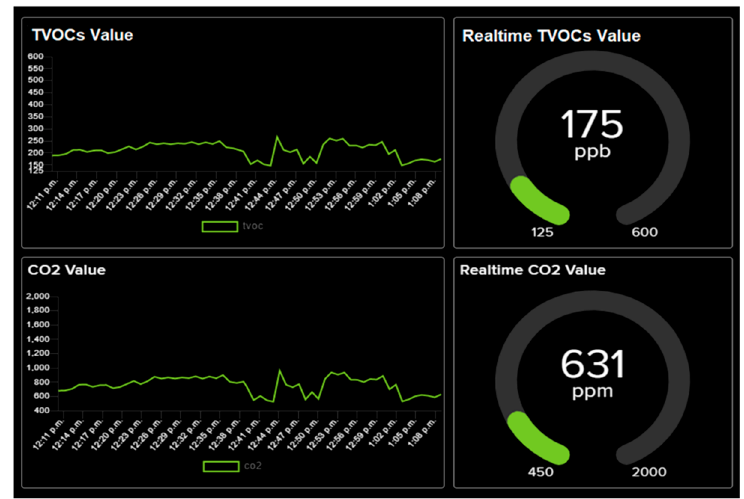
Figure 15. TVOCs and CO 2 measurement results on the monitoring terminal dashboard.